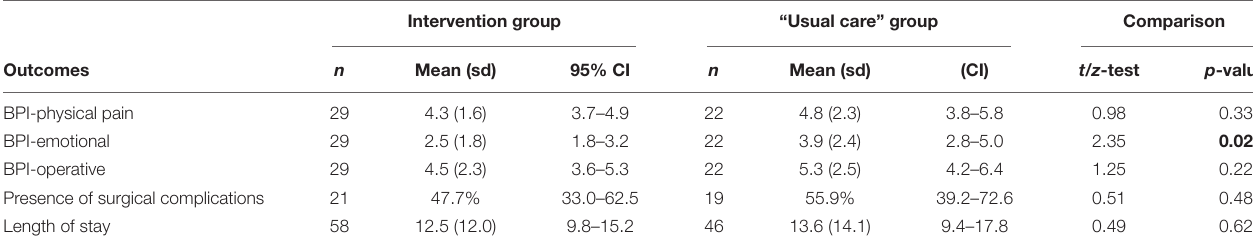
TABLE 6 | Secondary outcomes: measures collected after surgical intervention. Intervention group “Usual care” group